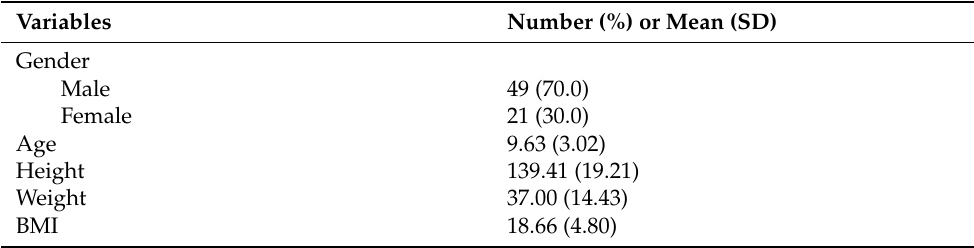
Table 1. Characteristics of the